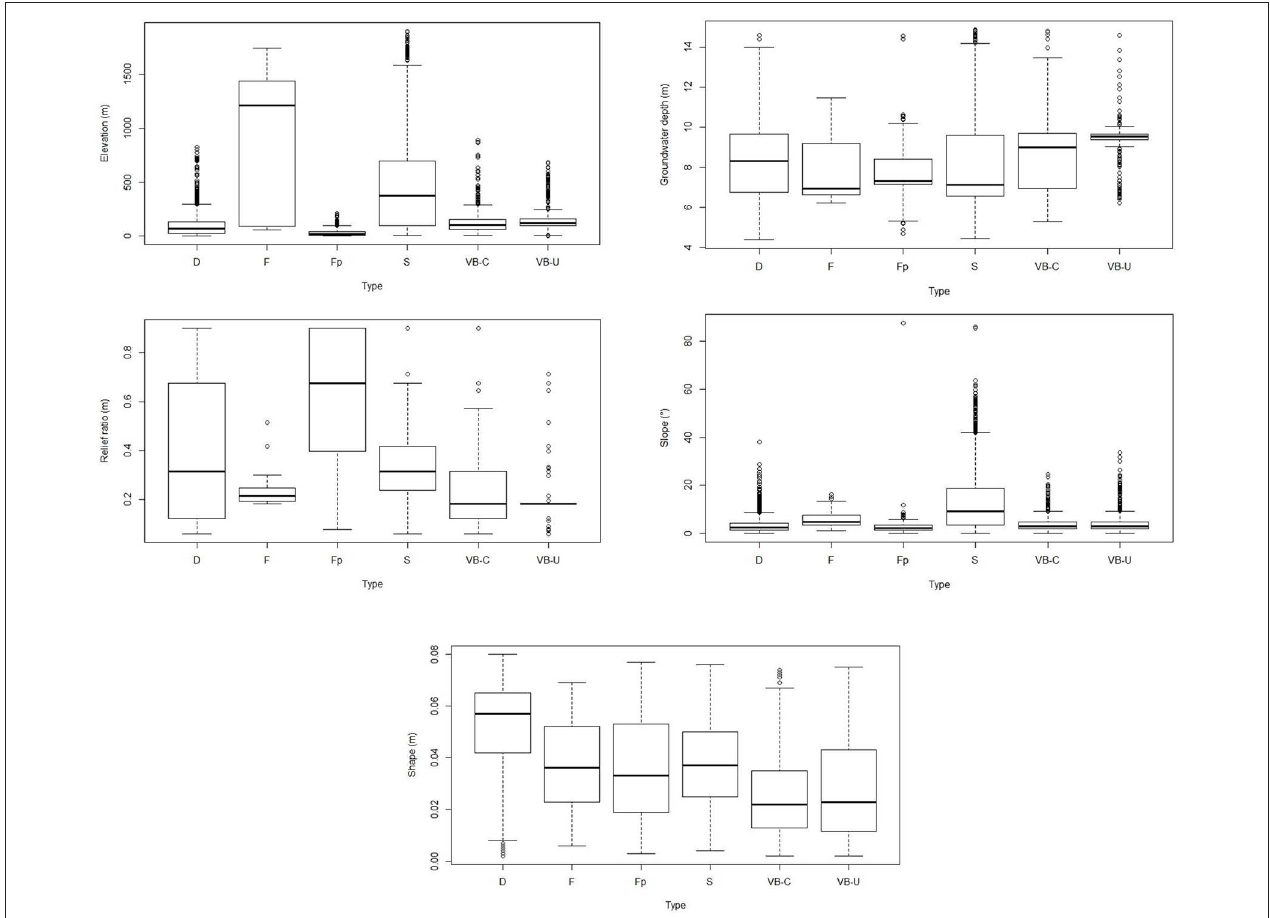
FIGURE 5 | Box-and-whisker plots of HGM type by elevation (top left); groundwater depth (m below ground) (top right); relief ratio (center left); slope (center right); and shape (bottom), where D, depression; F, flat; Fp, floodplain; S, seep; VB-C, channeled valley-bottom; and VB-U, unchanelled valley-bottom. Boxes indicate median values of metrics per HGM type plus 25th/75th percentiles, while whiskers indicate data range.